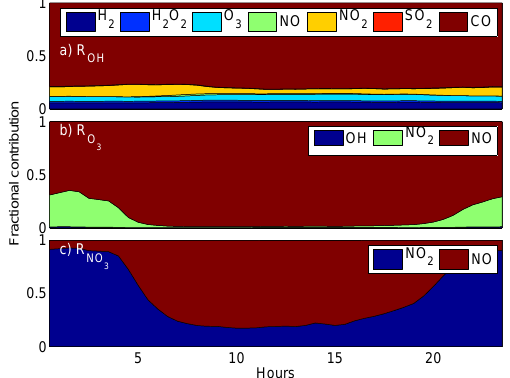
Figure 8. The daily averaged fractional contribution of individual inorganic compounds to the total Figure 10. The daily averaged fractional contribution of individual inorganic reactivity of OH (a) , O 3 (b) and NO 3 (c) at 18 m . inorganic compounds to the total inorganic reactivity of OH (a) , O 3 (b) and NO 3 (c) at 18m.